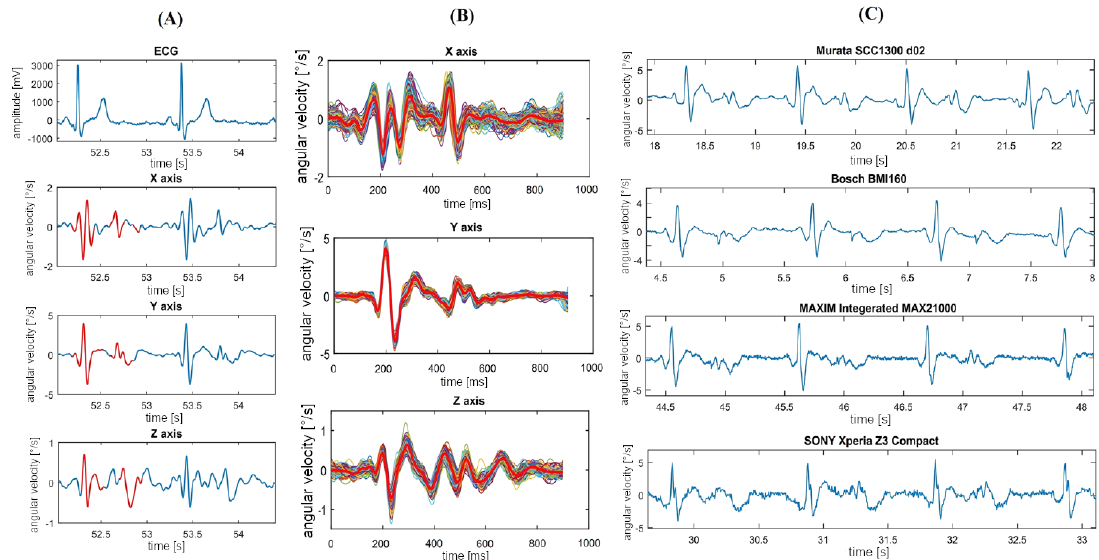
Figure 4. ( A ) Typical GCG waveforms in the x, y, and z axis and reference ECG signal. ( B ) 3-axis ensemble averaged GCG signals. ( C ) GCG waveforms in the y-axis obtained using different sensors (Murata SCC1300d02, Bosch BMI 160, Maxim Integrated MAX21000, and the SONY Xperia Z3 compact). The graph derived from the article [11] by Tadi et al. under the license CC-BY 4.0.